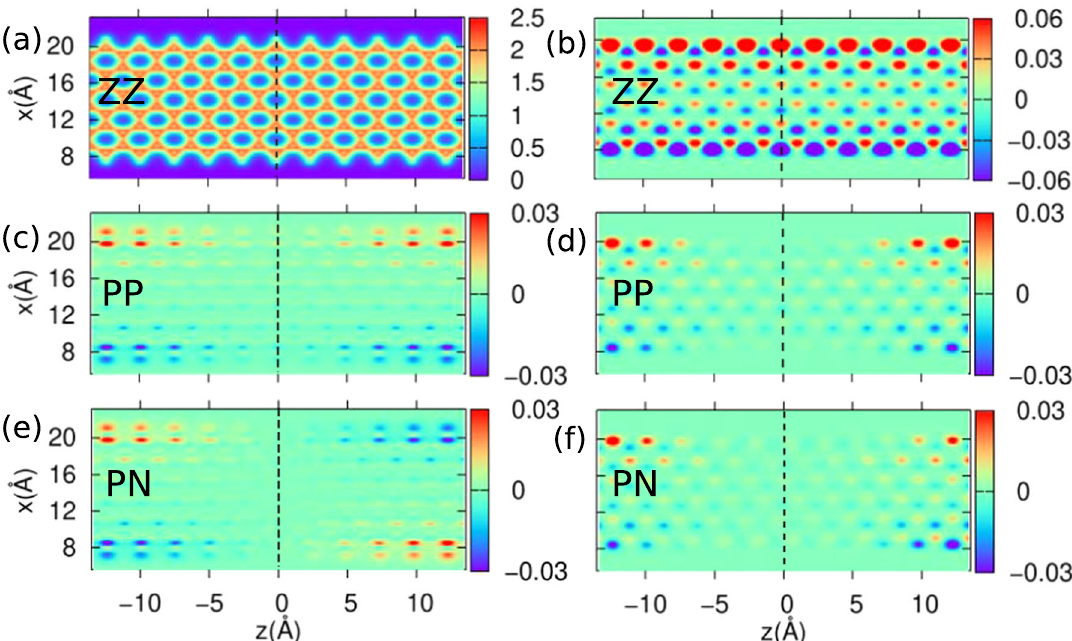
Fig. 3 Charge density and spin density distrubutions in different gate con fi gurations. a The charge density ρ (0) and b the spin density ρ s (0) of 6-ZGNR without any gate voltage. A positive (negative) value denotes spin-up (-down) component. The gate voltage-induced c charge density difference Δ ρ = ρ ( V g ) − ρ (0) and d spin density difference Δ ρ s = ρ s ( V g ) − ρ s (0) in “ PP ” con fi guration. The gate voltage-induced e Δ ρ and f Δ ρ s in “ PN ” con fi guration. V g is set to 12 V.